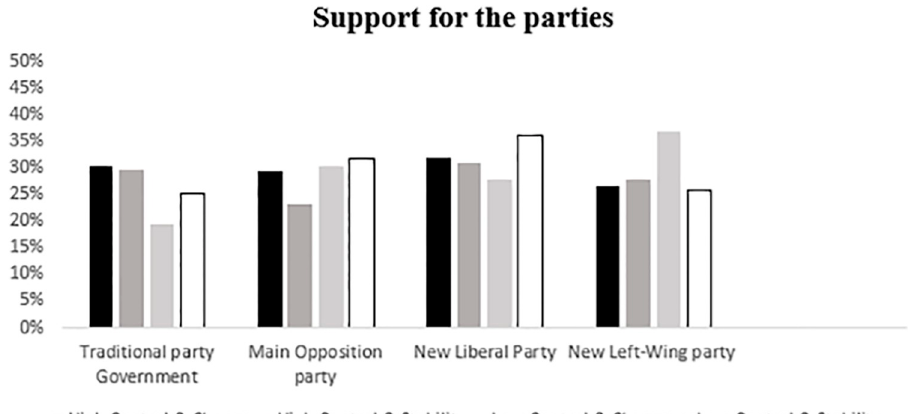
Fig 5. Support for the different political parties by experimental conditions (traditional party: